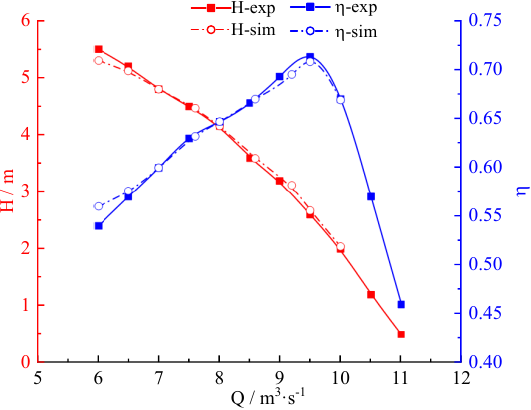
Figure 5. Forward characteristic curve.